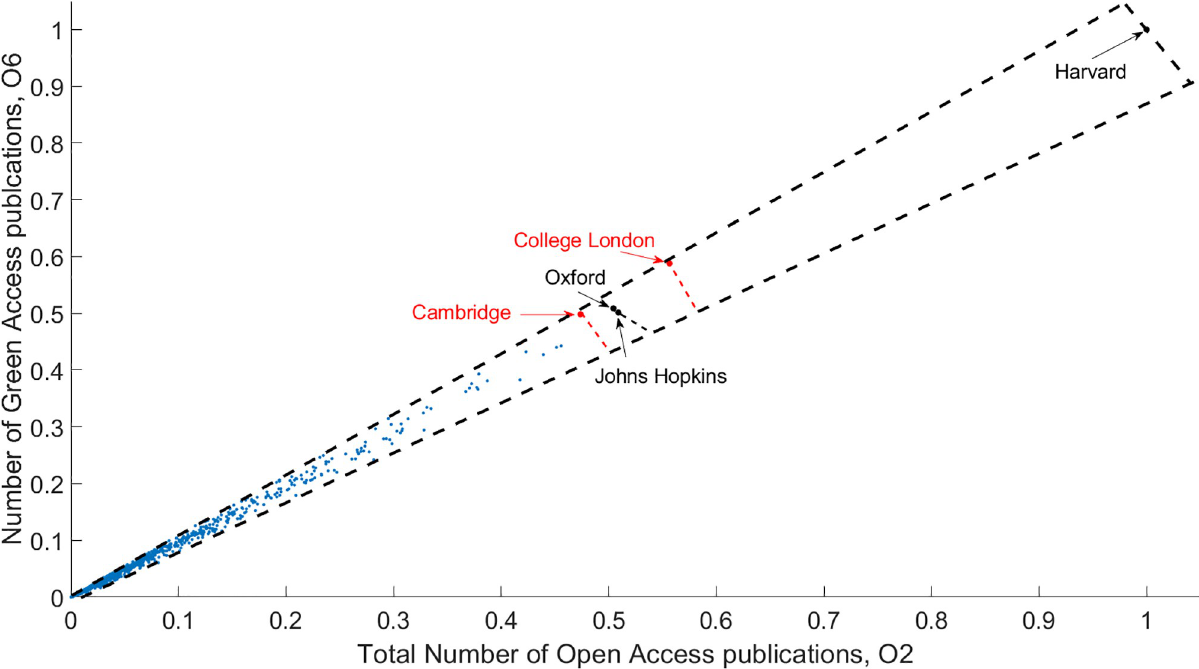
Fig 7. Pareto Front of the two objectives with the highest entropy. The Pareto fronts only consider those non-dominated solutions that are optimal from the viewpoints of the ‘total number of open-access publications’ (O2) and the ‘number of green access publications’ (O6). Coincidentally, the chosen objectives are one of the most correlating pairs. The other 44 objectives have no input to the ranking. Should another two dominant objectives taken into consideration, different non-dominated solutions would be obtained.